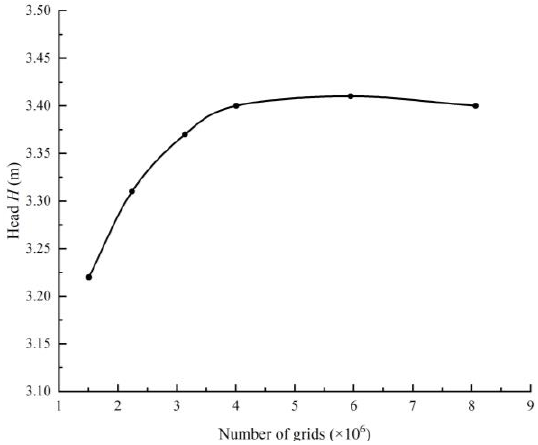
Figure 2. Grid independence analysis.